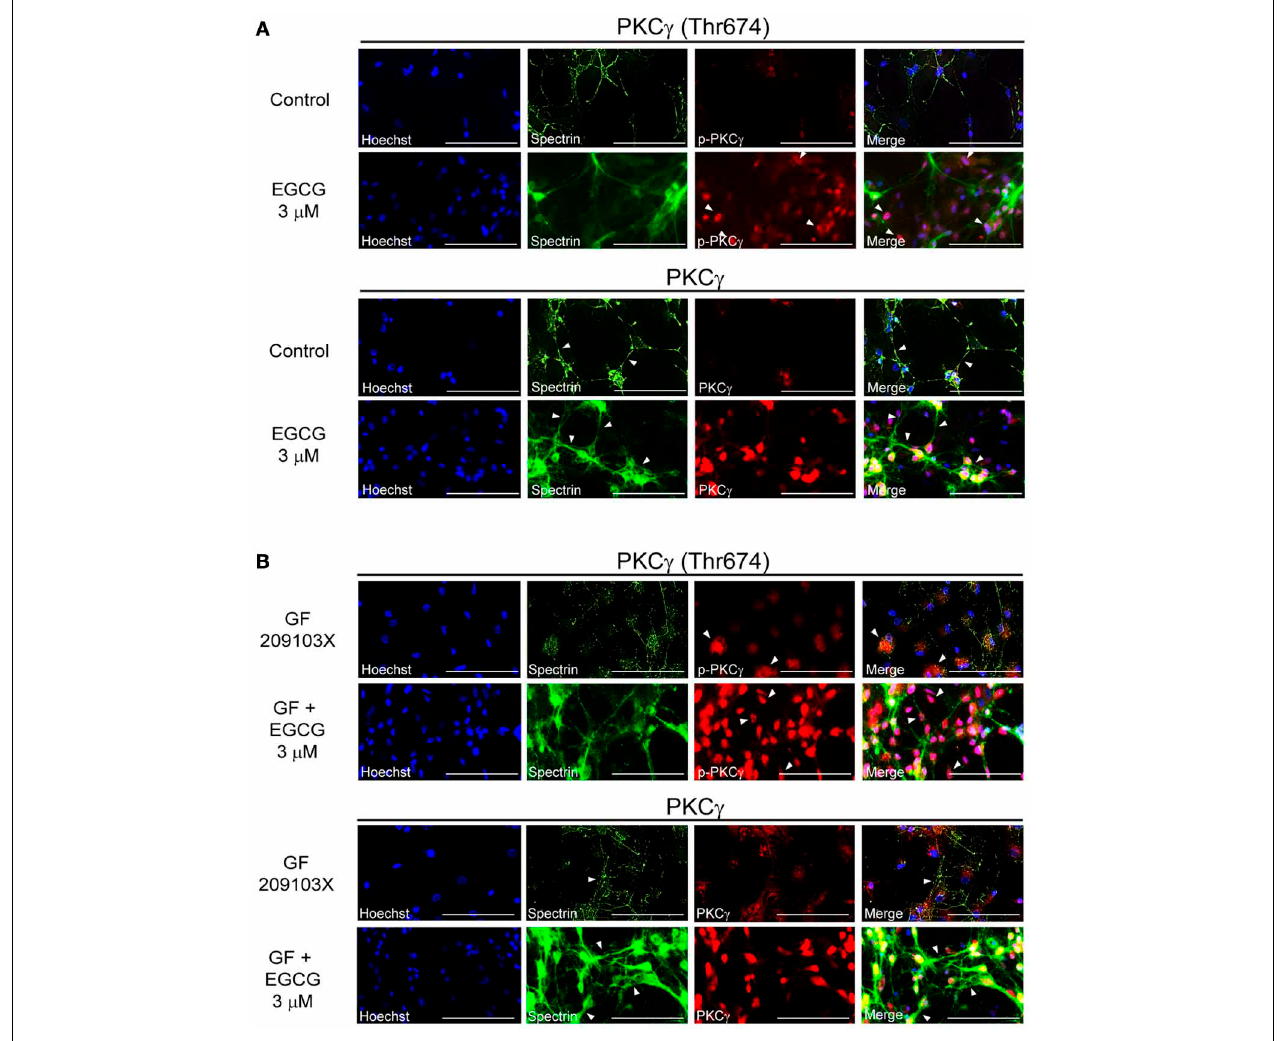
FIGURE 3 | EGCG enhances synaptic plasticity through PKC γ activation. (A) EGCG (3 μ M) treatment increased PKC γ expression, phosphorylation at the Thr674 site and facilitated neuronal interconnections. (B) This polyphenol can also prevent cytoskeleton